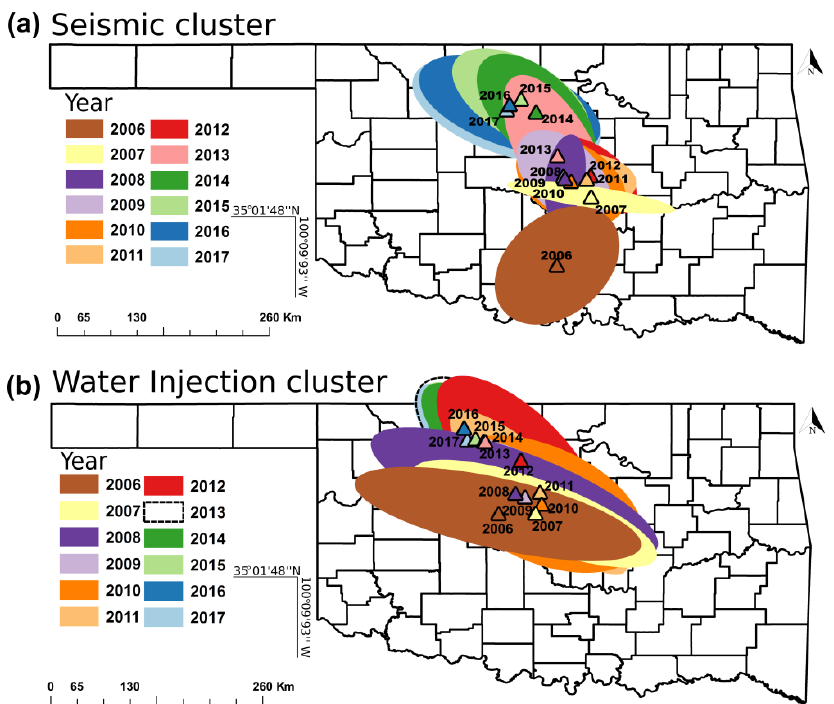
Figure 5. ( a ) Earthquake-clustering occurrence by year. Epicenters’ weighted mean centers (triangles) and standard deviation ellipses of all recorded earthquakes occurred in Oklahoma between 2006 and 2017; ( b ) Wastewater injection volume weighted mean centers (triangles) and standard deviation ellipses in Oklahoma between 2006 and 2017. The colors in both panels match for the same years, except by 2013 whose dashed lines are intended to improve result visualization. Coordinates of mean weighted centers are computed using Equation (1).